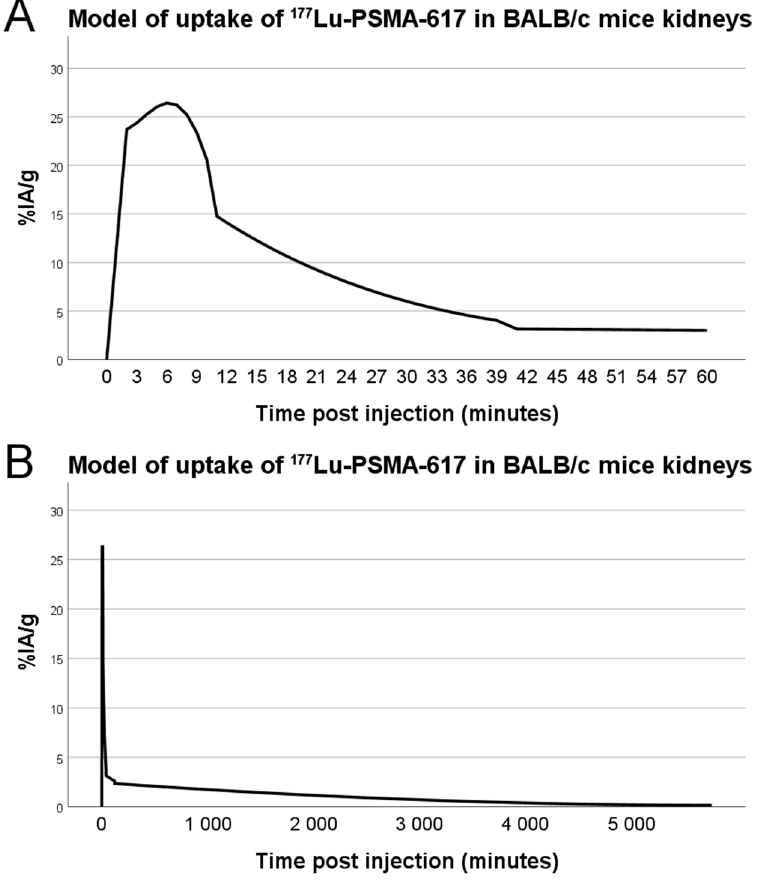
Figure 5. Model of uptake of [ 177 Lu]Lu-PSMA-617 in the kidneys of BALB/c male mice based on in vivo dynamic SPECT imaging (n = 8), ex vivo biodistribution measurements (n = 6) and literature data for 1-, 2- and 4-days post injection. Initial uptake ( A ) and long-time retention ( B ).